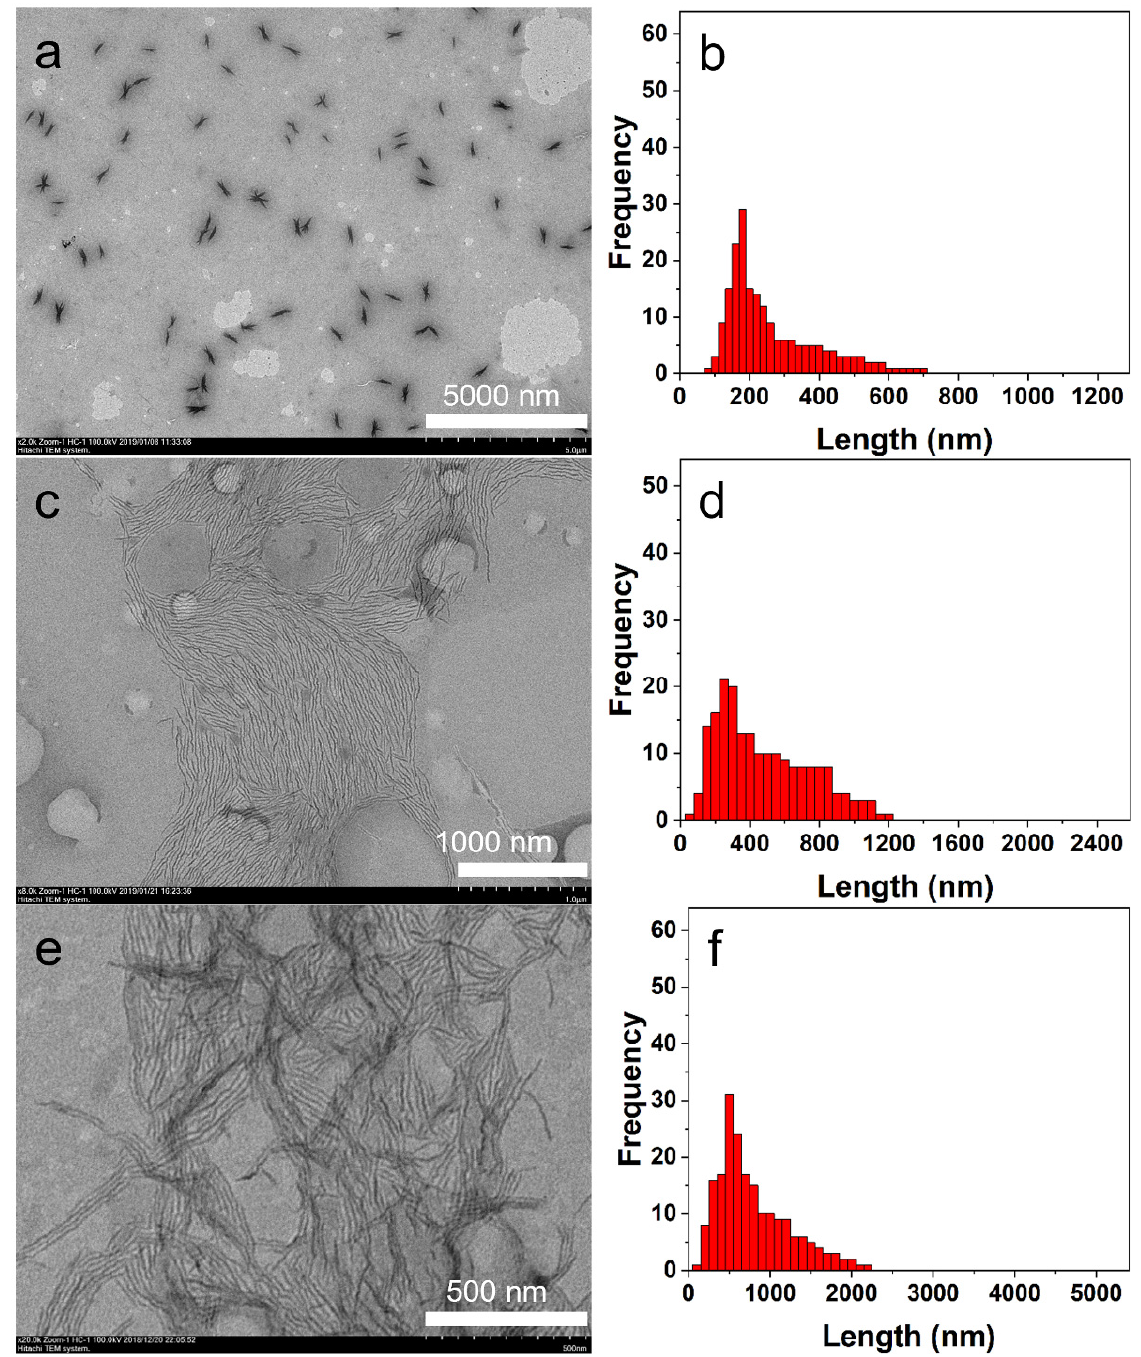
Figure 6. The TEM images and size distributions of the fibers self-assembled by P3HT 22 - b -PEG 113 in i -PrOH with different polymer concentrations. The TEM images of the fibers in solutions at c = 0.001 mg . mL − 1 ( a ), c = 0.015 mg . mL − 1 ( c ), and c = 0.03 mg . mL − 1 ( e ). The length distributions of the fibers in solutions at c = 0.001 mg . mL − 1 ( b ), c = 0.015 mg . mL − 1 ( d ), and c = 0.03 mg . mL − 1 ( f ).